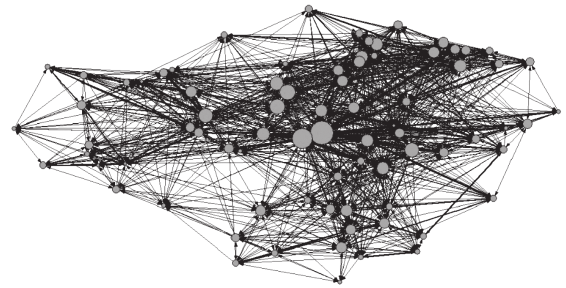
Fig. 1. Discipline knowledge network in